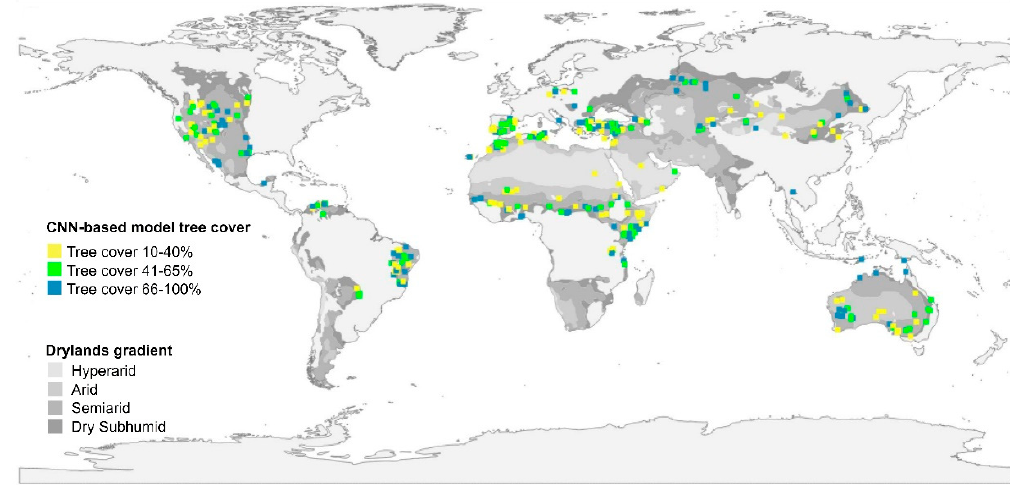
Figure 3. Tree cover of the 359 plots of 0.5 hectare (initial dataset 396 without 37 plots of uncertain class with score <50%) assessed in this study according to the CNN-based method proposed in this study. Yellow, green, and blue for Open Forest (tree cover 10–40%), Closed Forest (tree cover 41–65%), and Dense Forest (tree cover 66–100%), respectively. Drylands aridity map from UN Environment Programme World Conservation Monitoring Centre UNEP-WCMC: Hyperarid (Aridity Index AI < 0.05), arid (0.05 ≤ AI < 0.2), semiarid (0.2 ≤ AI < 0.5), and dry subhumid (0.5 ≤ AI < 0.65).